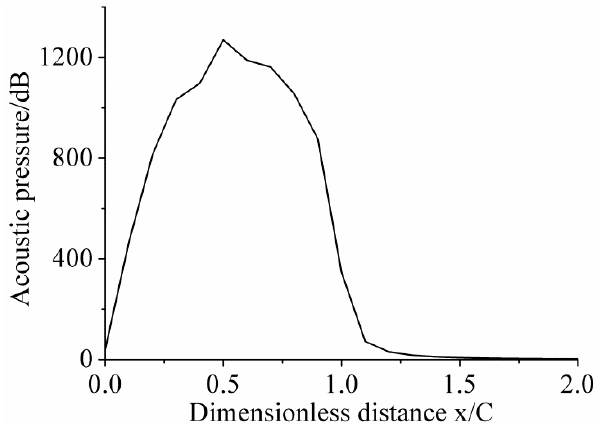
Figure 22. The variation in acoustic pressure along the hydrofoil surface for σ = 3.3.